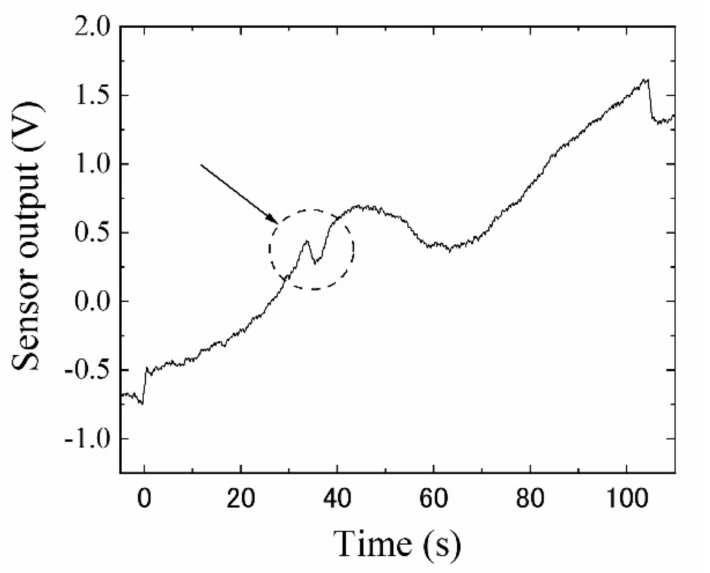
Figure 18. Measurement result when the small steel chip was set on the work piece, as shown in Figure 15. The dotted circle indicates the signal of magnetic chip. (Feeding speed: 10